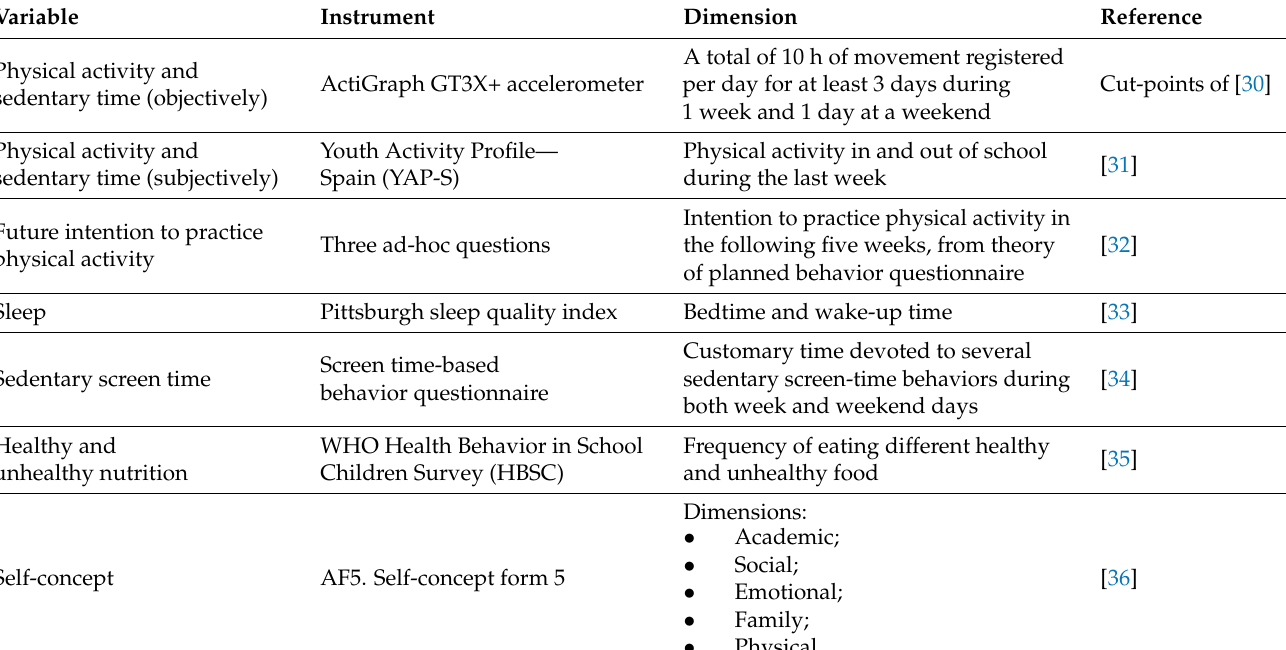
Table 2. Variables and instruments to evaluate the effectiveness of the intervention